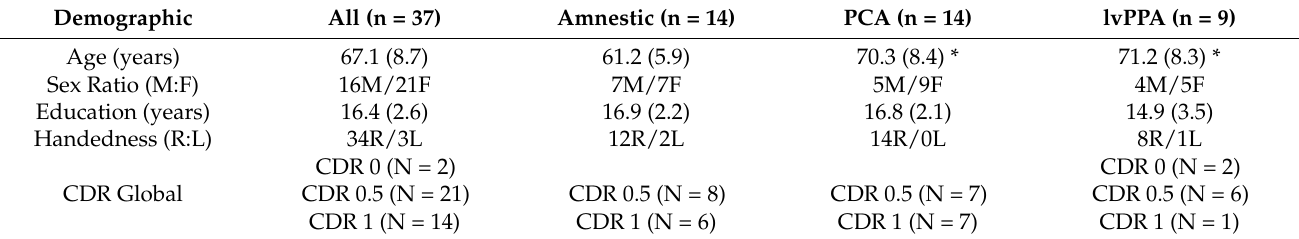
Table 1. Demographic characteristics. Mean (SD) presented for each continuous demographic factor.